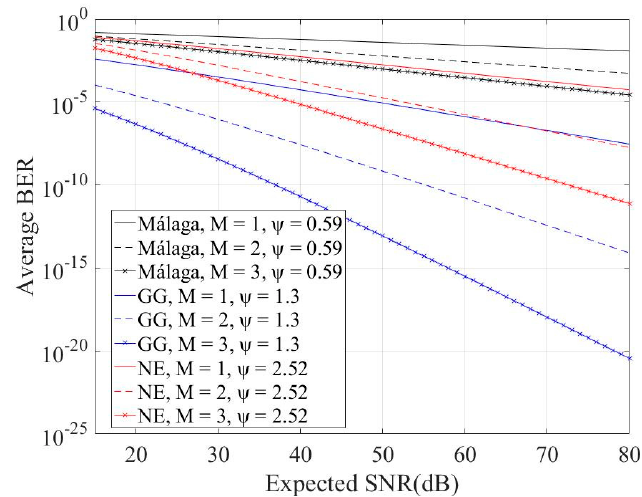
Figure 2. OP performance versus the normalized outage threshold for NE case.